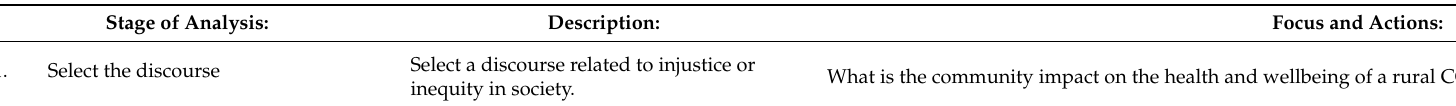
Table 1. Framework of Mullet’s CDA [25] applied to this case